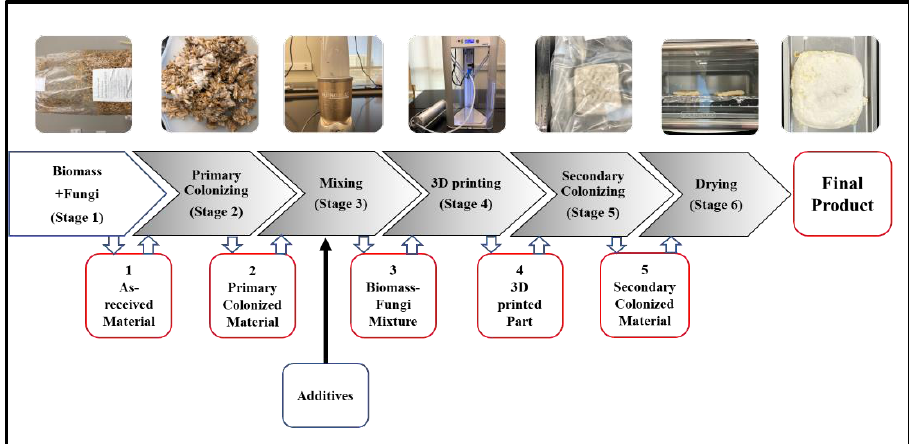
Figure 1. Six stages of the 3D printing-based method for biomass – fungi composites.